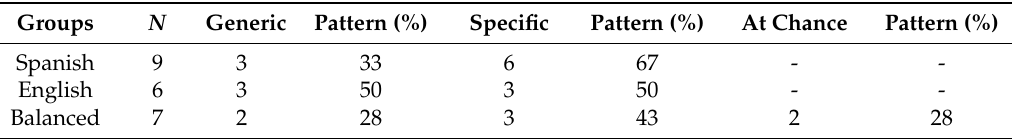
Table 4. Definite NPs: Individual subject patterns by amount of